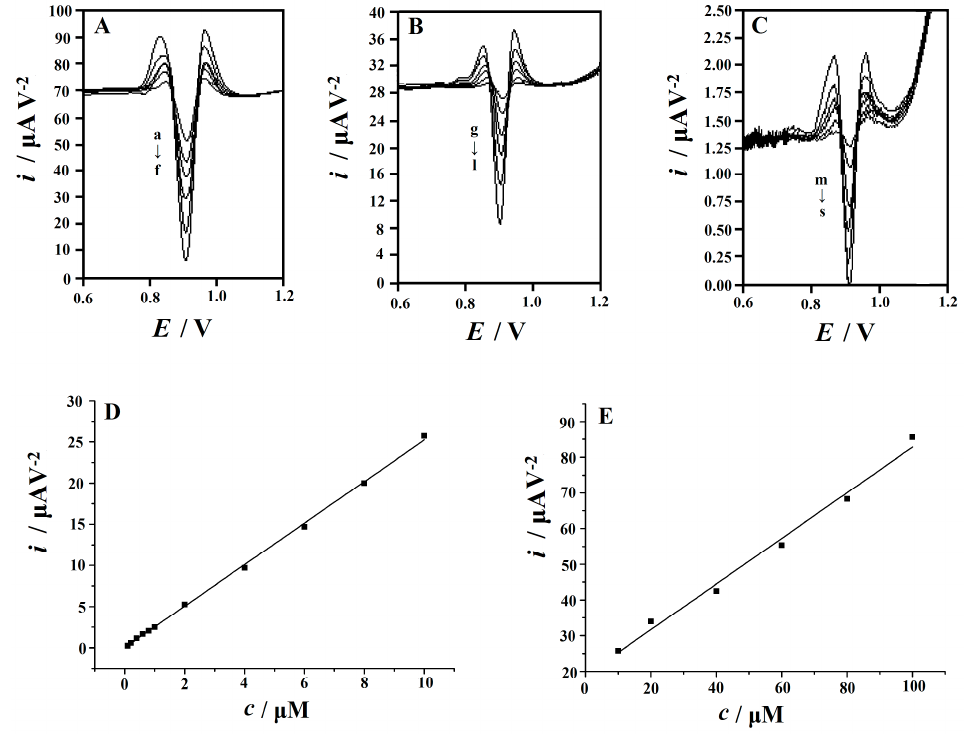
Figure 9. Second-order derivative linear scan voltammograms obtained at Cu 2 O-ERGO/GCE in 0.1 M H 2 SO 4 solution containing different concentrations of vanillin. ( A ) From a to f: 10, 20, 40, 60, 80, 100 μ M; ( B ) From g to l: 1, 2, 4, 6, 8, 10 μ M; ( C ) from m to s: 0.1, 0.2, 0.4, 0.6, 0.8, 1.0 μ M; ( D ) plot of the oxidation peak currents as a function of vanillin concentrations: 0.1 − 10 μ M ( E ); plot of the oxidation peak currents as a function of vanillin concentrations: 10–100 μ M. Accumulation potential: 0.0 V, accumulation time: 90 s, scan rate: 0.1 V s − 1 .